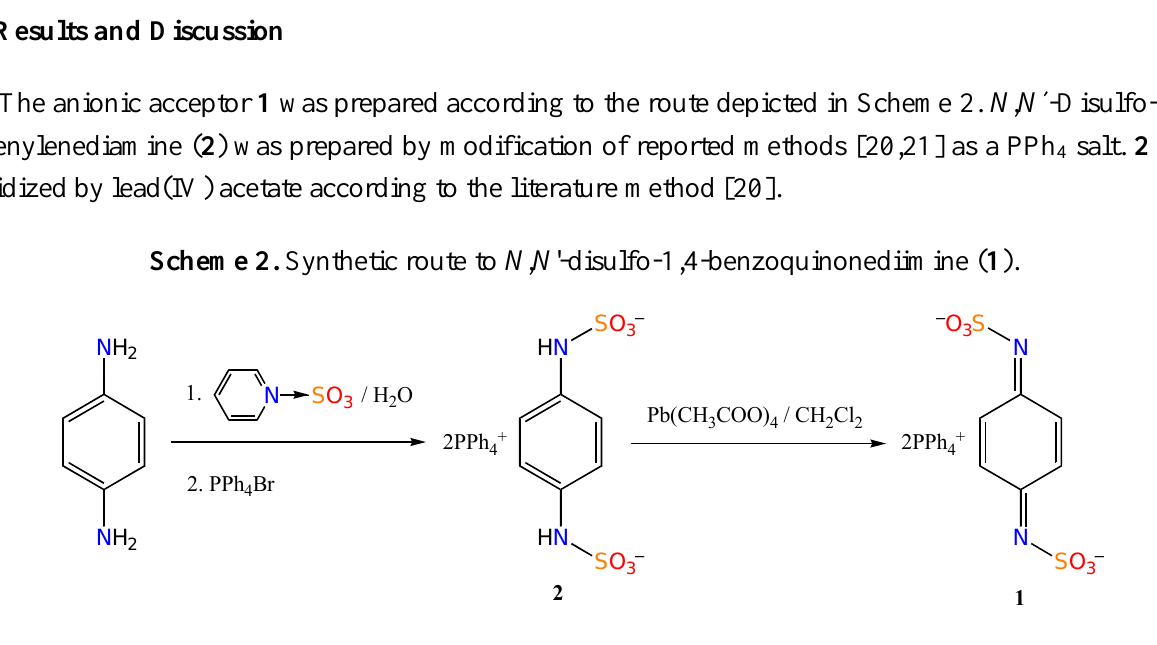
) 2 ·DCE, (b) 1 in (PPh 4 2